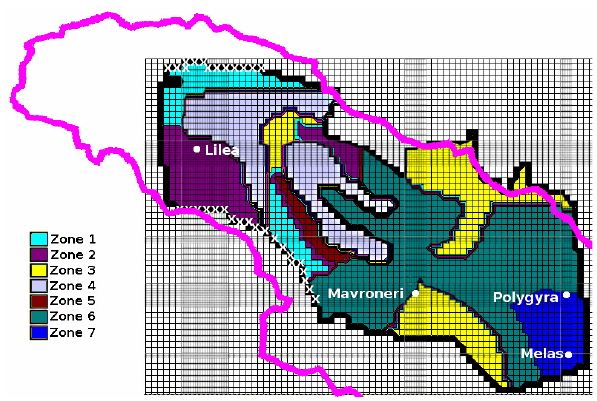
Fig. 3. Discretization of the karst aquifer and zonation employed in framework A (with the springs, part of the basin boundaries, and the dummy wells: x = recharge, o = pumping).